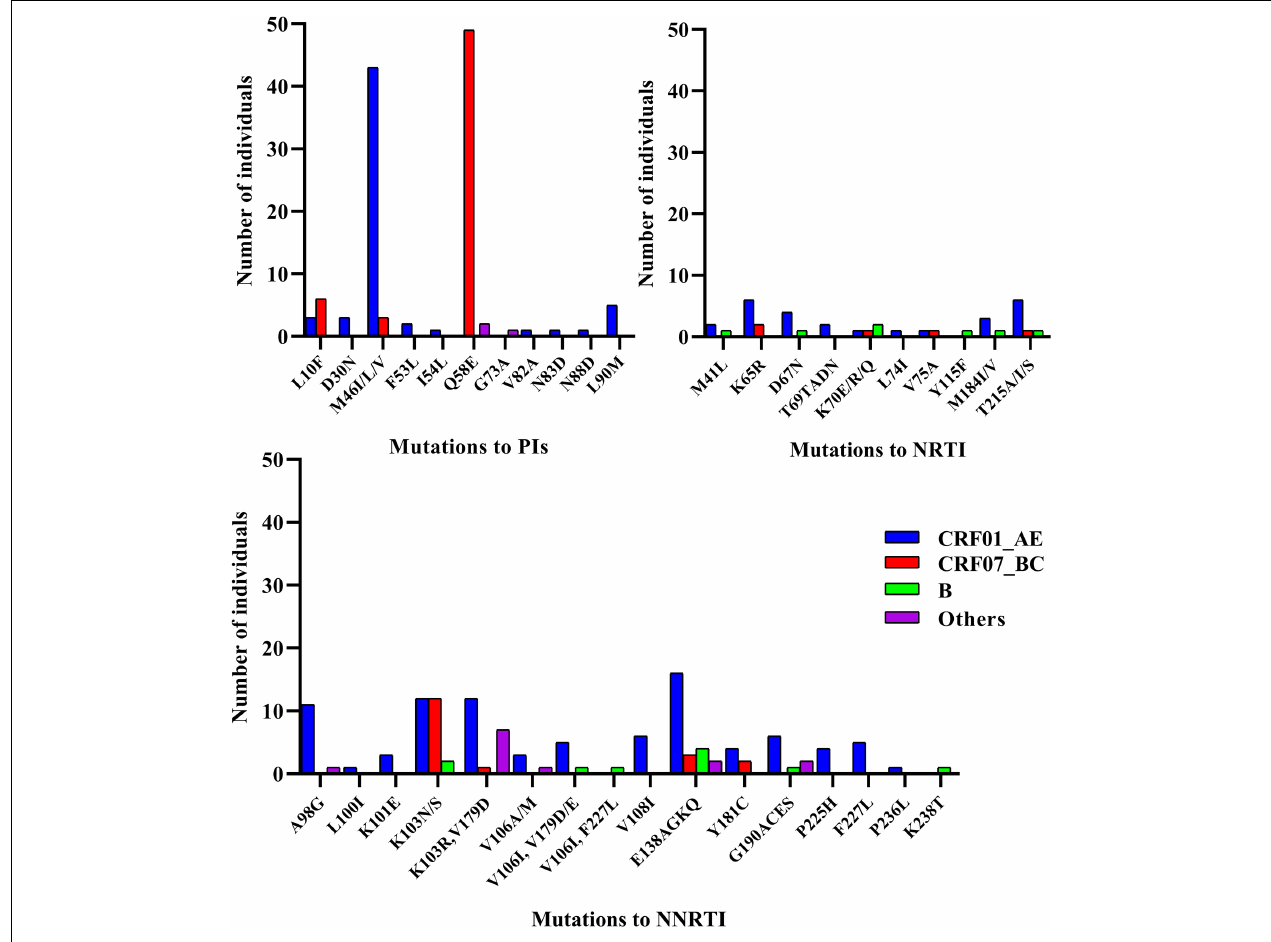
FIGURE 2 | The number of TDR mutations according to gene position.